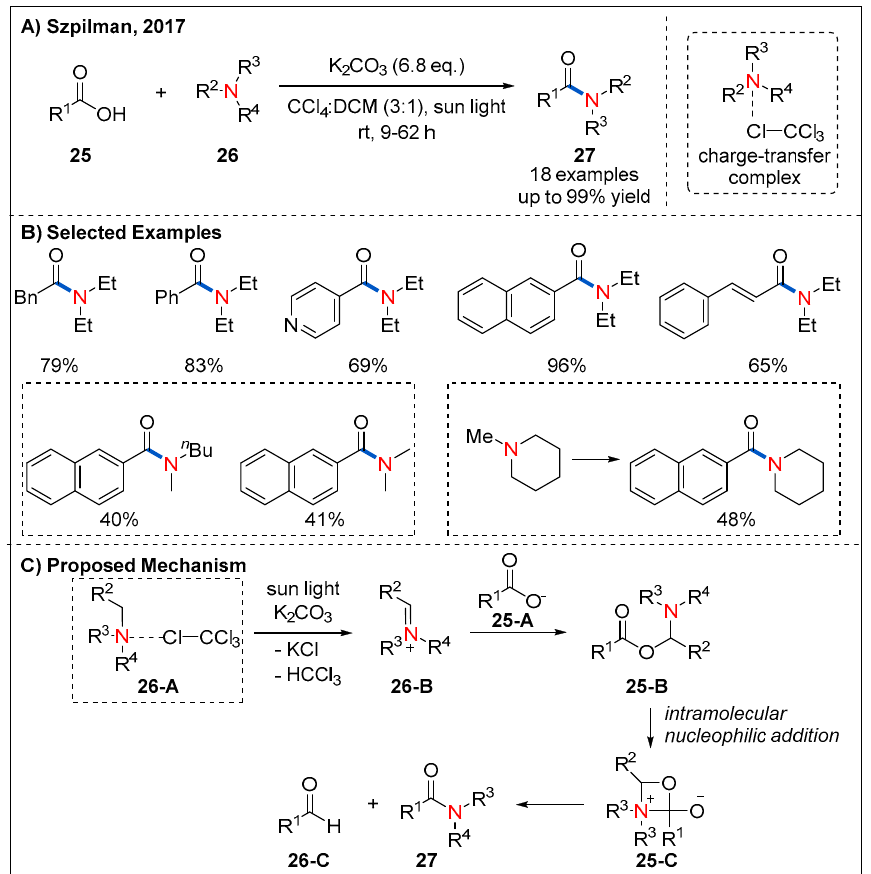
Figure 11. Sunlight-assisted direct dealkylative amide formation via a charge-transfer